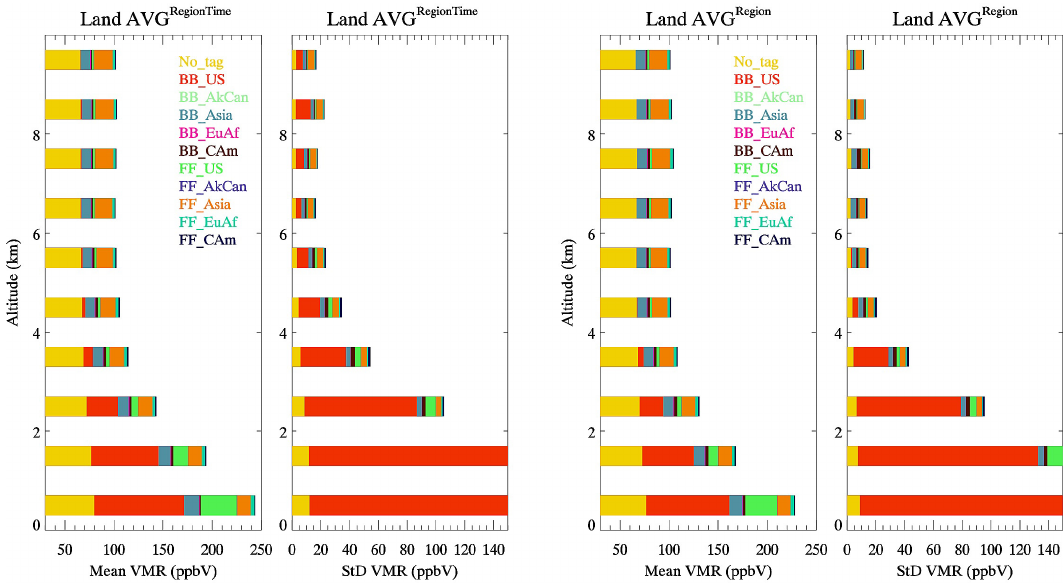
Fig. 6. As Fig. 4 but for AVGRegionTime and AVGRegion Land Data Sets.